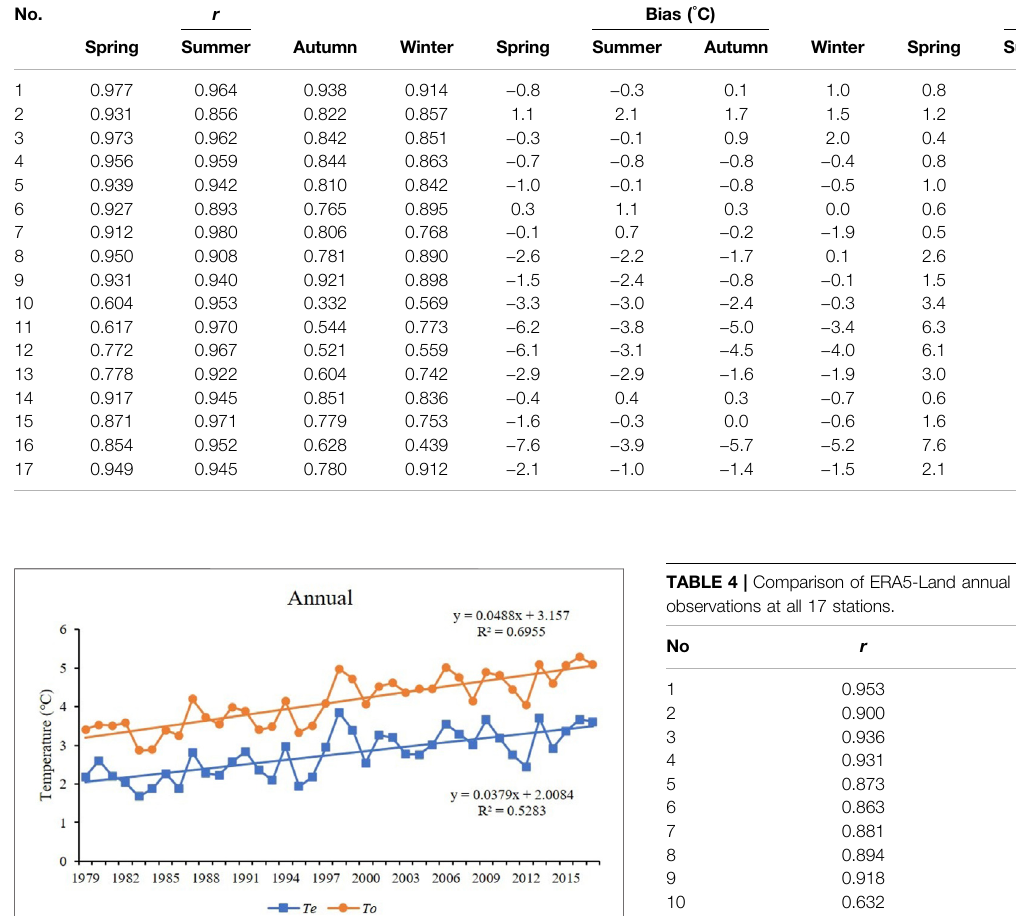
TABLE 3 | Comparison of ERA5-Land seasonal mean temperature with observations at all 17 stations. No. r Bias ( ° C) RMSE ( ° C) Spring